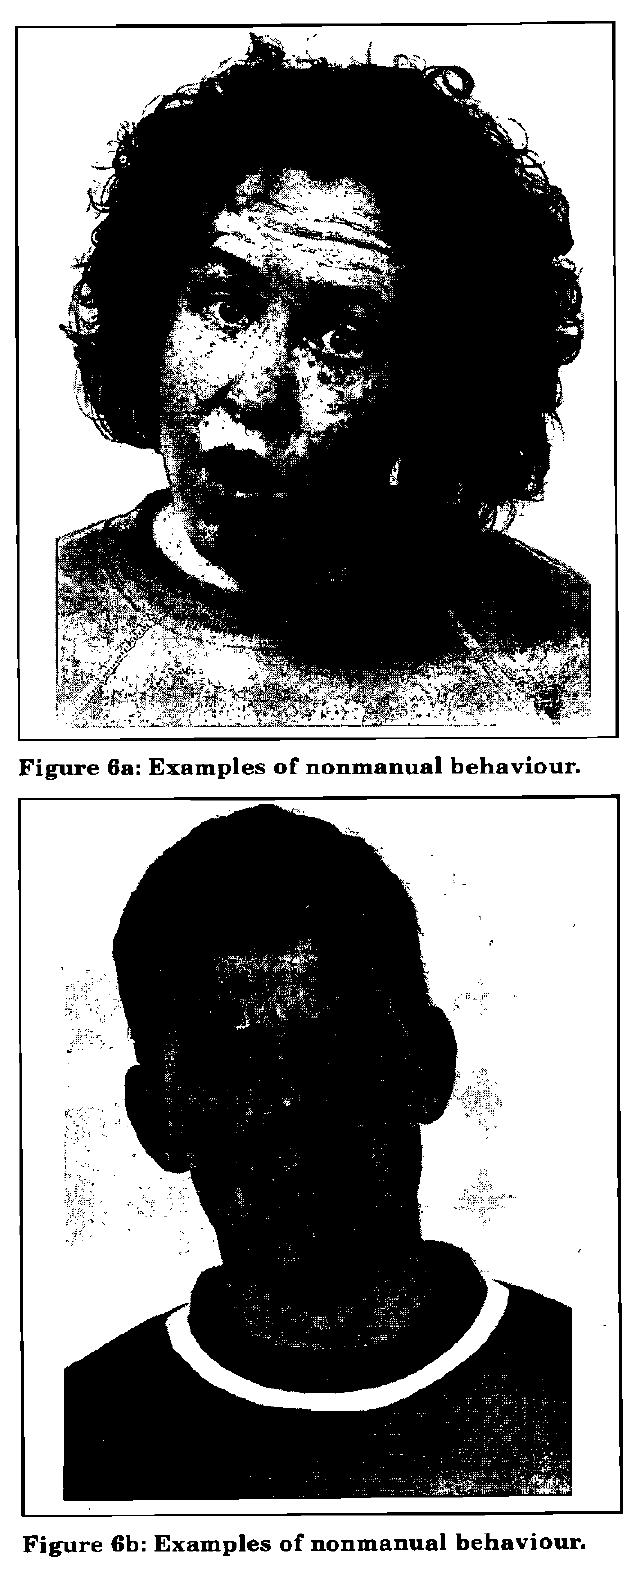
Figure 6b: Examples of nonmanual